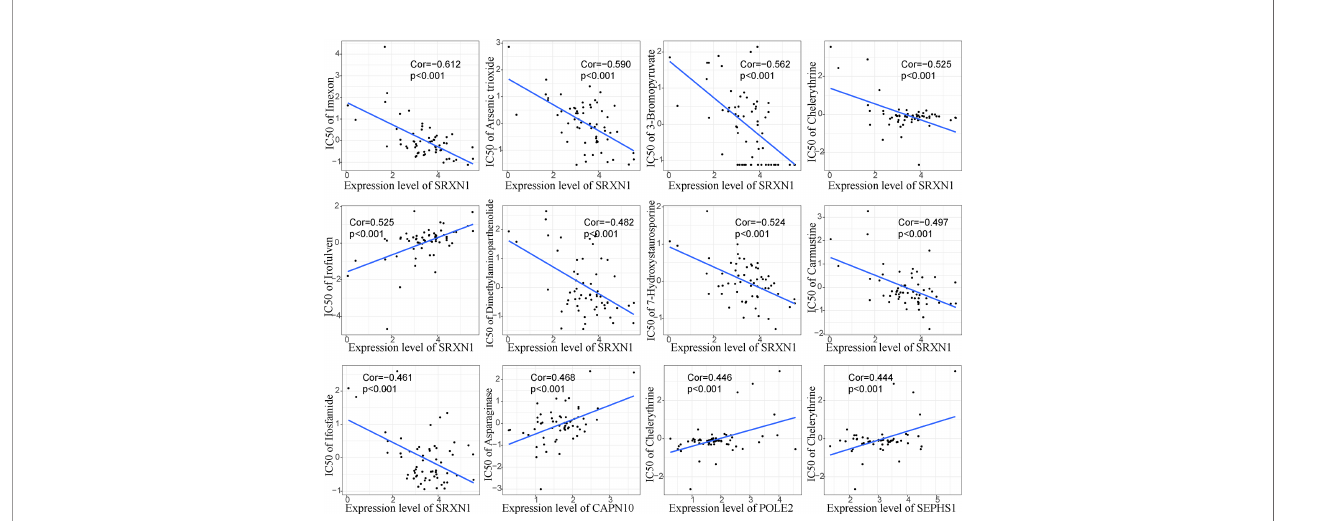
FIGURE 8 | Pearson correlation analysis between the fi fteen prognostic genes and their potential targeted drugs. Twelve representative scatter plots of the relationship between drug sensitivity (IC50) and the expression levels of the fi fteen hub genes. Positive correlation means that with the increase of gene expression level, the IC50 value of drugs also increases, and vice